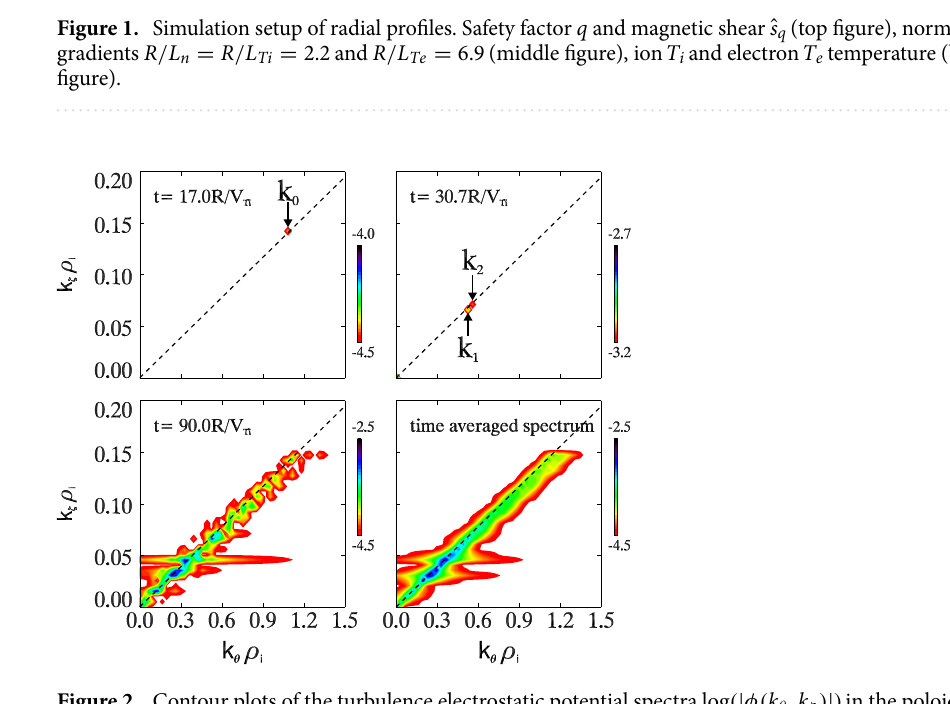
φ( k θ , k ζ ) ) in the poloidal-toroidal Figure 2. Contour plots of the turbulence electrostatic potential spectra log ( | | k ζ ρ i ) domain. At time t 17.0 R / V Ti (late linear phase), 30.7 R / V Ti (early nonlinear wave number ( k θ ρ i − = phase), 90.0 R / V Ti (fully nonlinear phase) and time-averaged spectrum in the nonlinear saturation. Black dash lines indicate the approximate mode rational